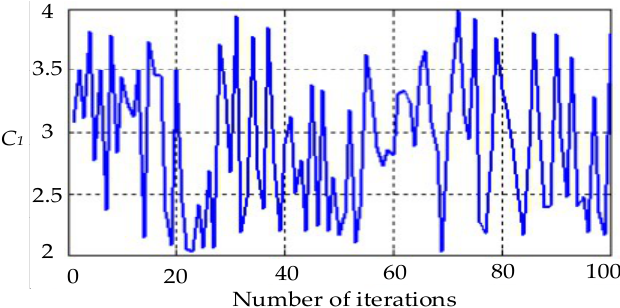
Figure 4. Trend of cognition learning factor C 1 combining ABC and PSO.